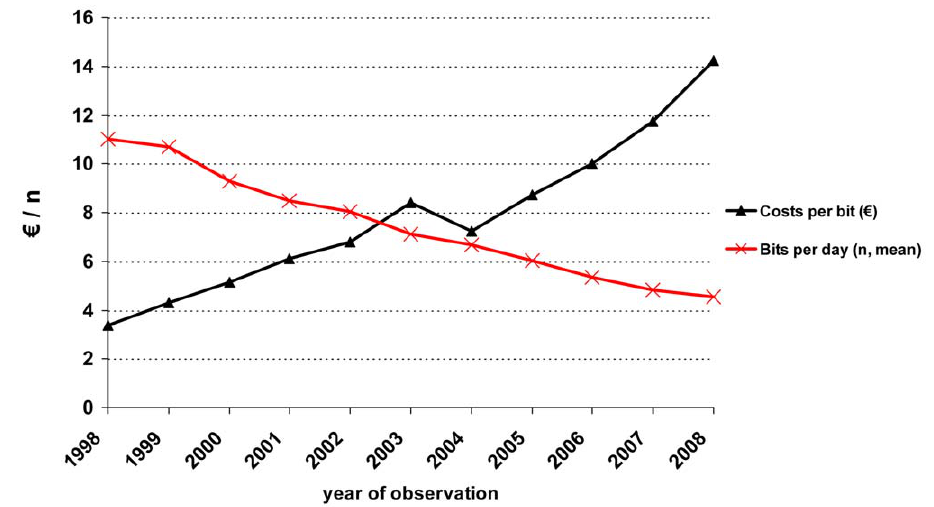
Figure 6. Means of daily taken pills (bit) and average costs of each single antiretroviral pill by year.